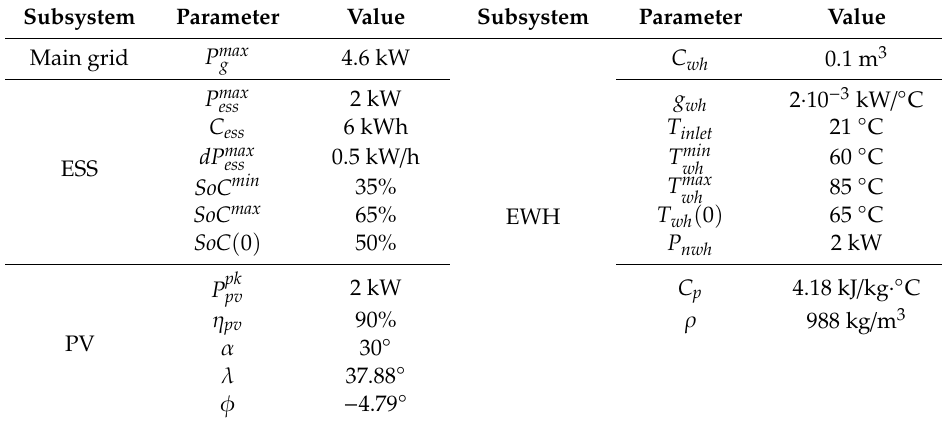
Table 1. Main parameters of the